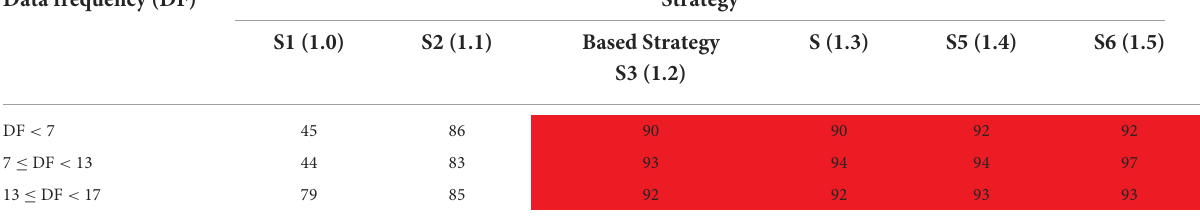
TABLE 8B Probabilities of the OPREM meeting the higher band width given the data frequency. Data frequency (DF)